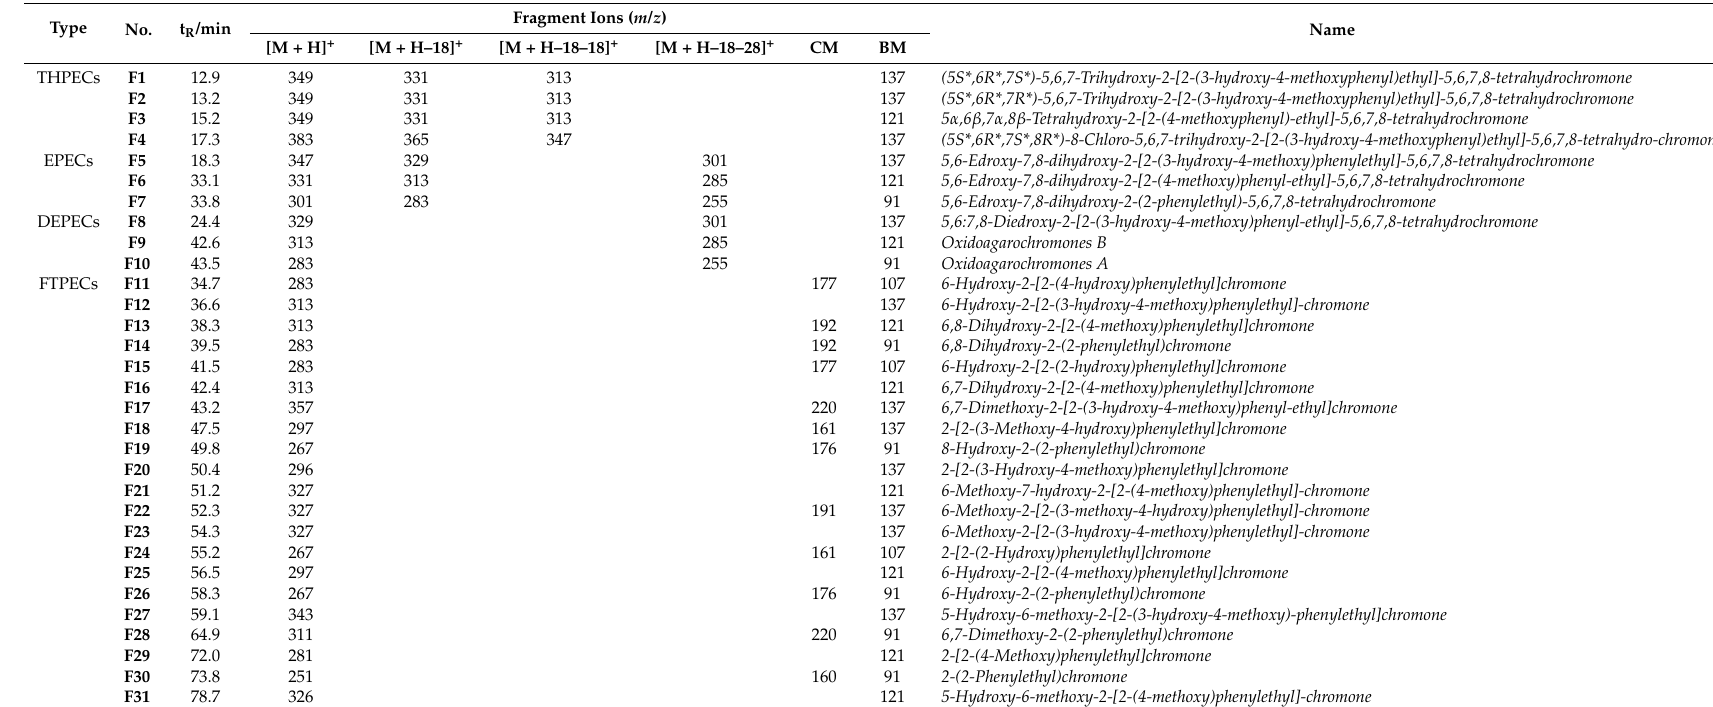
Table 1. Characterization of thirty-one reference compounds by